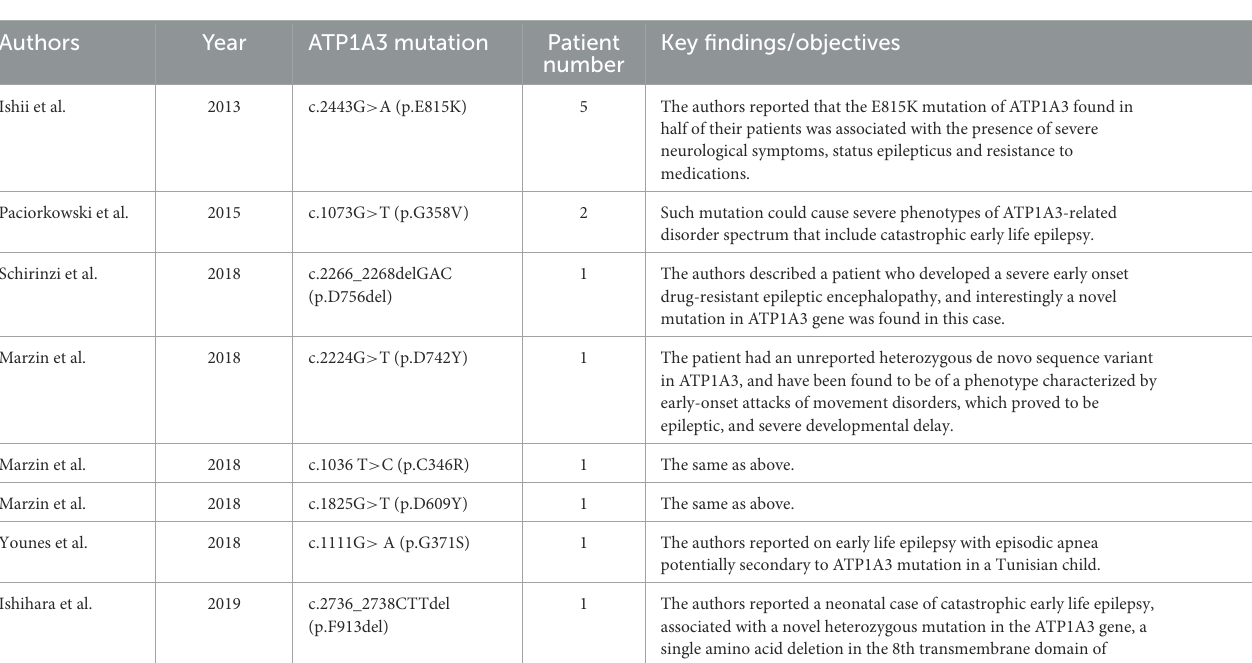
TABLE 1 Summary of clinical findings involving ATP1A3-related